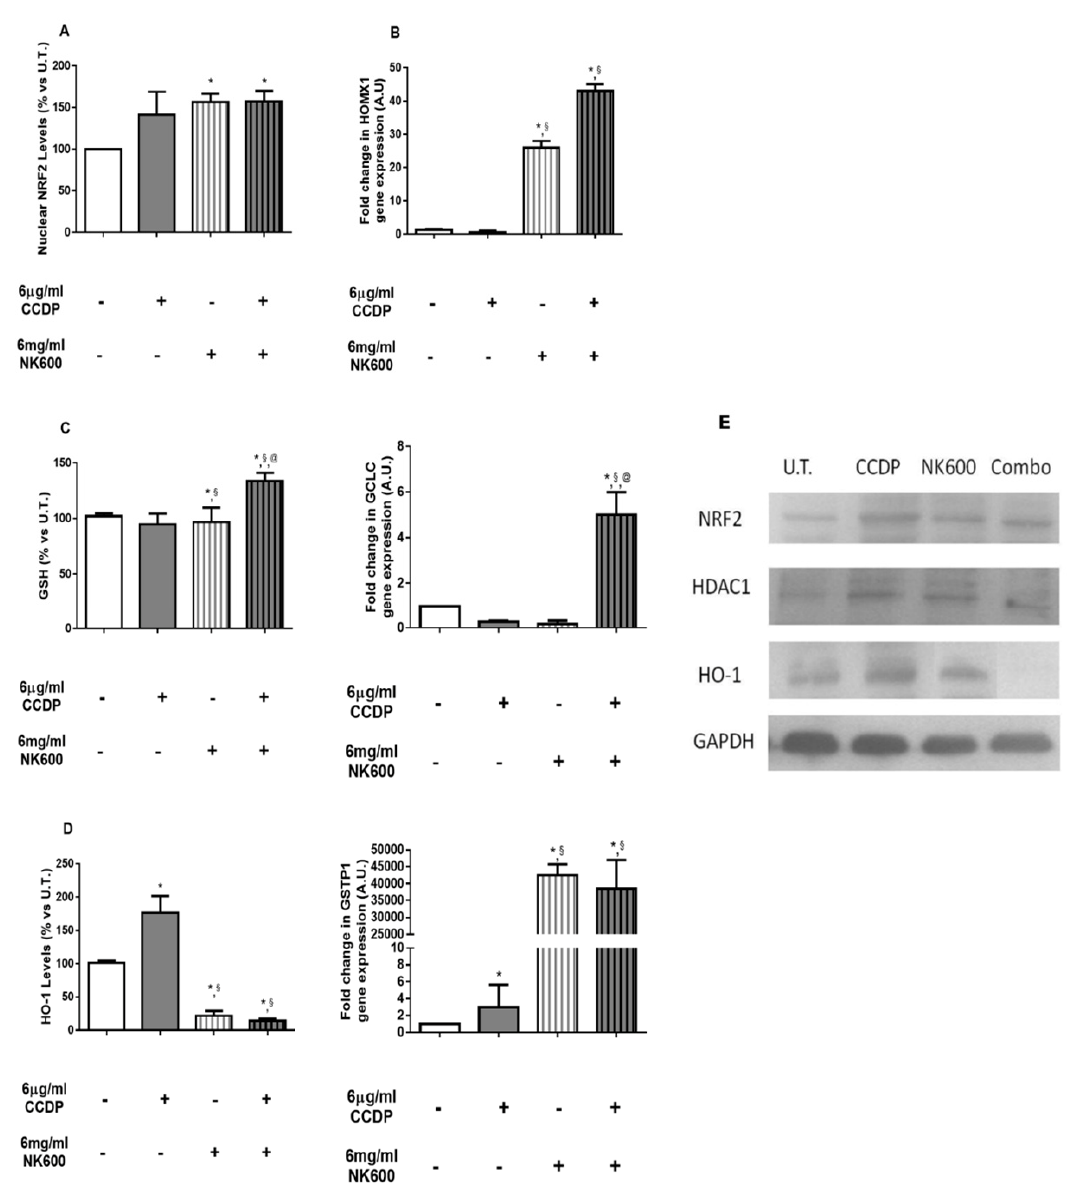
Figure 4. Antioxidant response analysis. ( A ) Nuclear levels of NRF2 protein were evaluated in DLD1 after 6 h of 6 µ g/mL of CCDP, 6 mg/mL of NK600, and Combo 6 exposure. The analysis was performed by immunoblotting and the bars are expressed as % vs. untreated (U.T.) DLD1 cultures. ( B ) Gene expression analysis was performed on DLD1 after 12 h of 6 μ g/mL of CCDP, 6 mg/mL of NK600, and Combo 6 exposure.HOMOX1, GCLC, and GSTP1 data are expressed as fold-increases relative to untreated cultures at the same end-point, and they are normalized to GAPDH housekeeping gene expression. ( C ) GSH levels in DLD1 after 24 h of 6 µ g/mL of CCDP, 6 mg/mL of NK600, and Combo 6 exposure. The cellular GSH concentration was determined by fluorimetric analysis and is expressed as % vs. U.T. cells. ( D ) HO-1 protein levels were evaluated in DLD1 after 48 h of 6 μ g/mL of CCDP, 6 mg/mL of NK600, and Combo 6 exposure. The analysis was performed by immunoblotting and the bars are expressed as % vs. untreated (U.T.) DLD1 cultures. ( E ) The figures depicted are representative of at least three similar immunoblot analyses: NRF2 and HO-1 protein levels in untreated DLD1, and in treated DLD1 (6 μ g/mL of CCDP, 6 mg/mL of NK600, and Combo 6). HDAC1 and GAPDH were used as internal controls for equal protein loading on gels. The data represent the mean ± standard deviation (SD) of 3 independent experiments. * treated DLD1 vs. U.T. DLD1; §CCDP vs. NK600/Combo6; @NK600 vs. CCDP/Combo 6. * p < 0.01; § p < 0.01; @ p < 0.01 (two-way ANOVA followed by Bonferroni’s test).